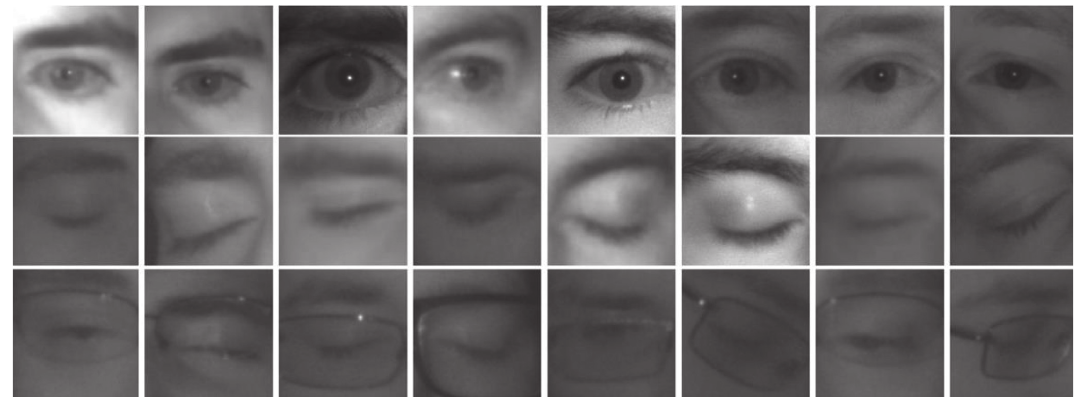
Figure 13: MRL eye dataset